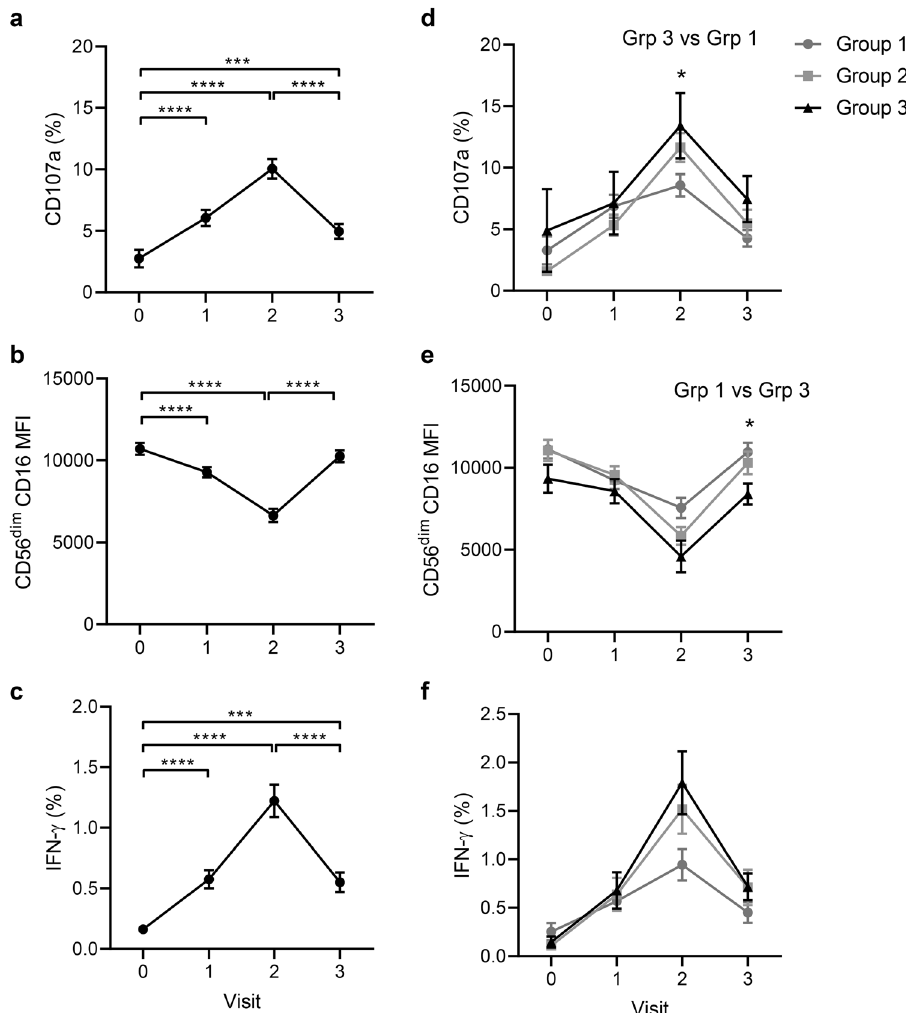
Fig. 2 Durable antibody-dependent NK cell responses to immobilised EBOV GP. CD107a ( a , d ), CD16 MFI ( b , e ), and IFN- γ ( c , f ) expression among NK cells from a standard PBMC population (from a single unvaccinated donor) cultured with serum samples from individual trial donors collected pre-vaccination (visit 0), on day 29, 57 or 85 post-dose 1 (visit 1), 14 days post-dose 2 (visit 2) and 180 days post-dose 2 (visit 3). Data are shown for all vaccination groups combined ( a – c ) and by individual vaccination group ( d – f ) (see Table 1 for number of participants). Plots show mean values with standard error of the mean (s.e.m.). Across visit ( a – c ) and intergroup ( d – f ) comparisons were performed using one-way ANOVA mixed effects analysis with Geisser – Greenhouse correction. * p < 0.05, *** p < 0.001, **** p <